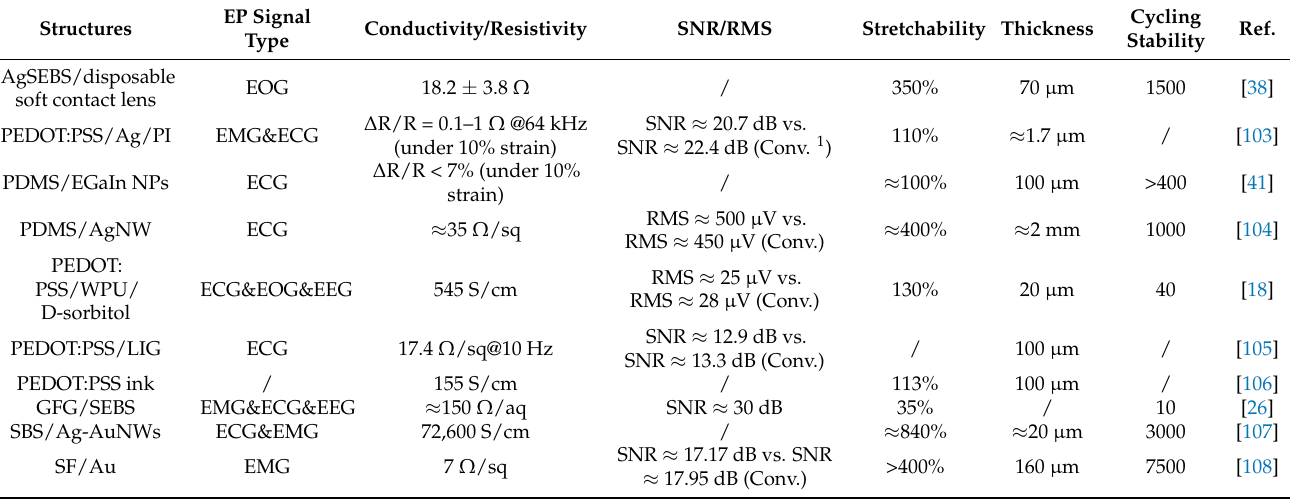
Table 1. Performance comparison of flexible EP